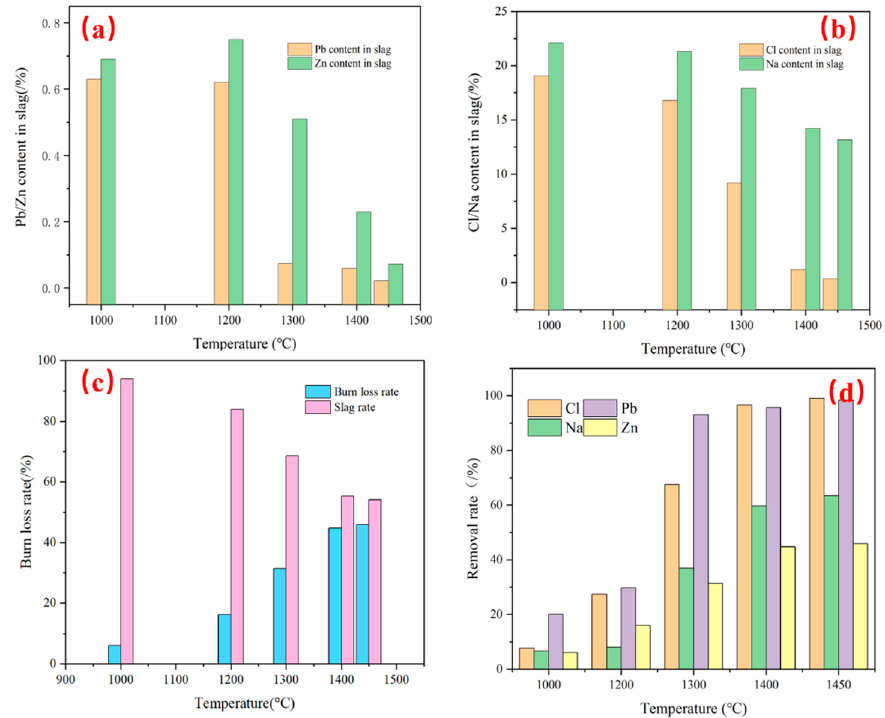
Figure 5. The effect of melting temperature over: ( a ) Cl and Na content in slag; ( b ) Pb and Zn content in slag; ( c ) ignition loss ratio and slag ratio; ( d ) distribution ratio of Cl, Na, Pb, and Zn in soot.